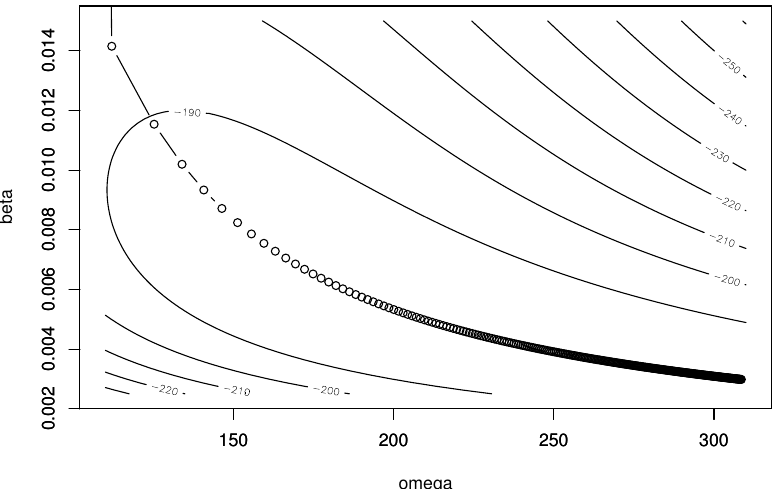
Figure 1. Trace of parameters in the EM